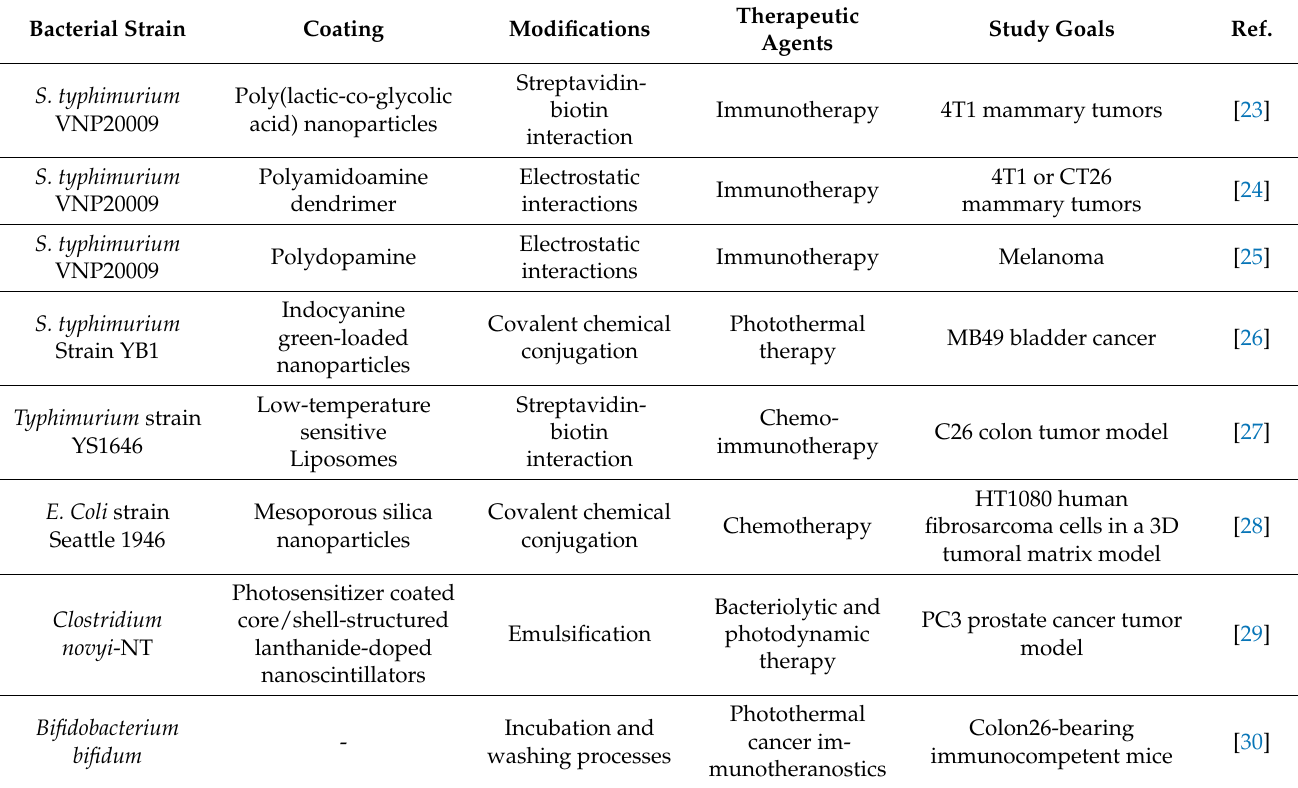
Table 1. The application of bacteria in different nano-drug delivery systems. Bacterial